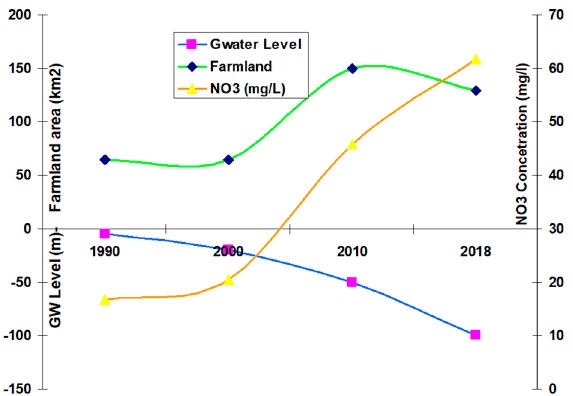
Figure 14. Relationship between built-up area (km 2 ) and water usage of household (mcm) and groundwater level (m).